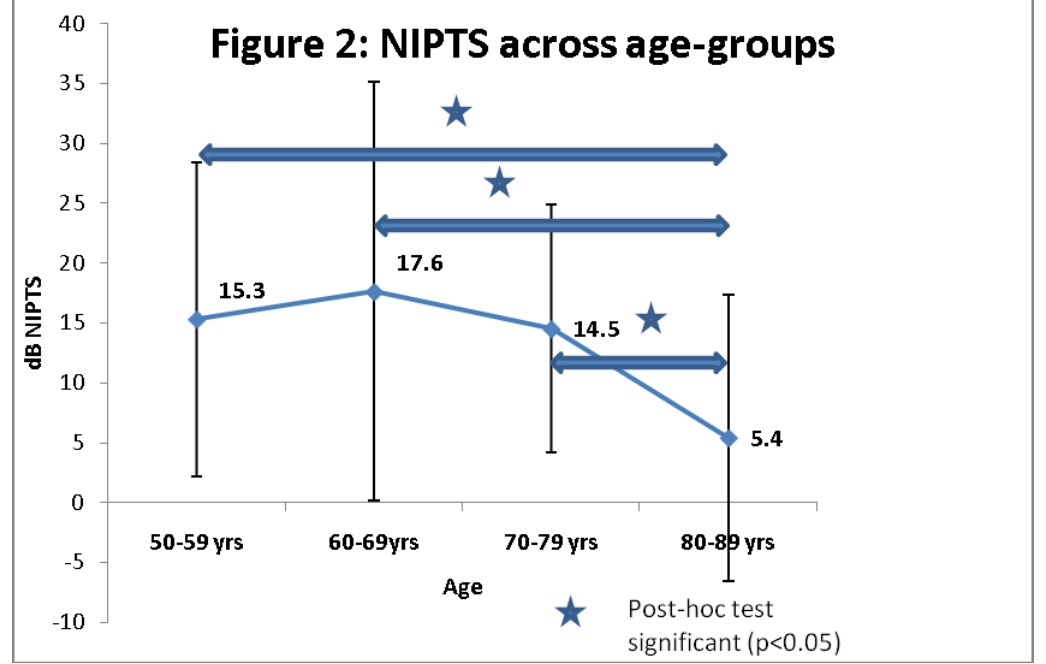
Figure 2. NIPTS across age-groups after